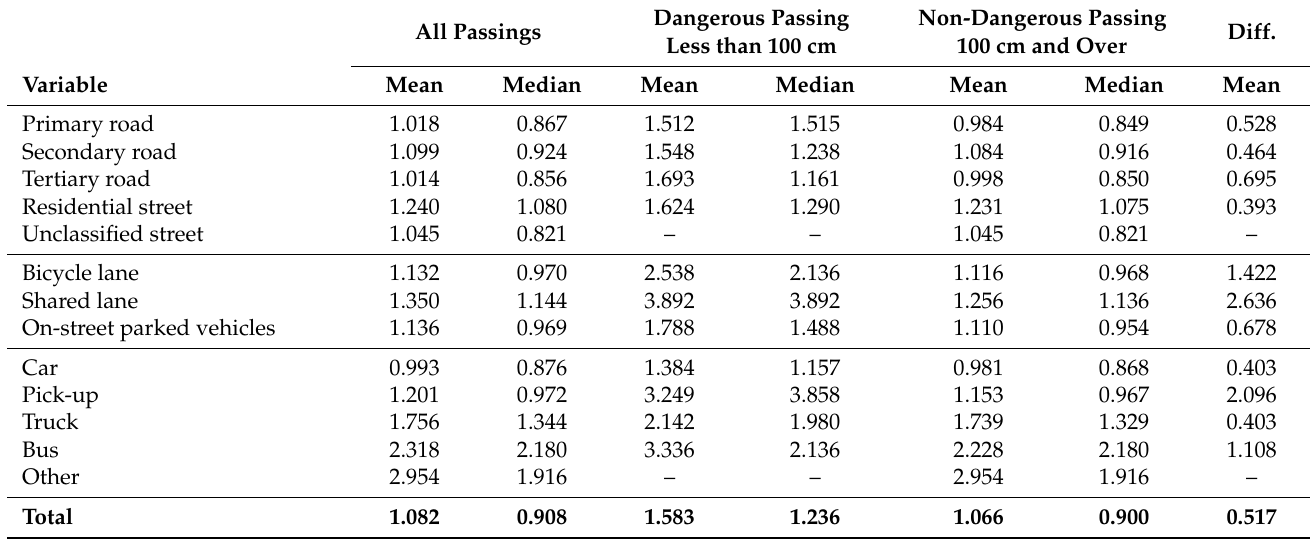
Table 3. Duration of lateral passings (dangerous or not) in